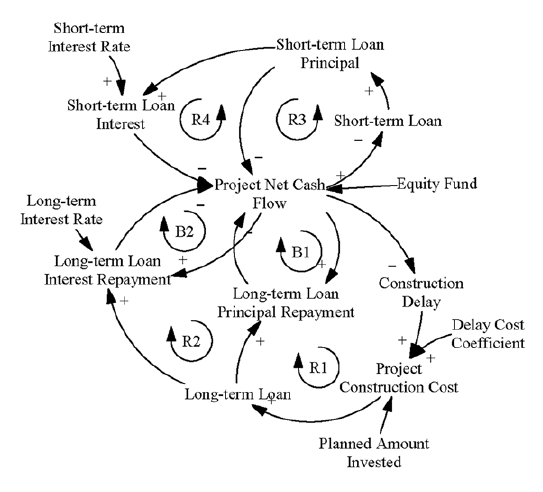
Figure 2. Causal loop diagram for finance